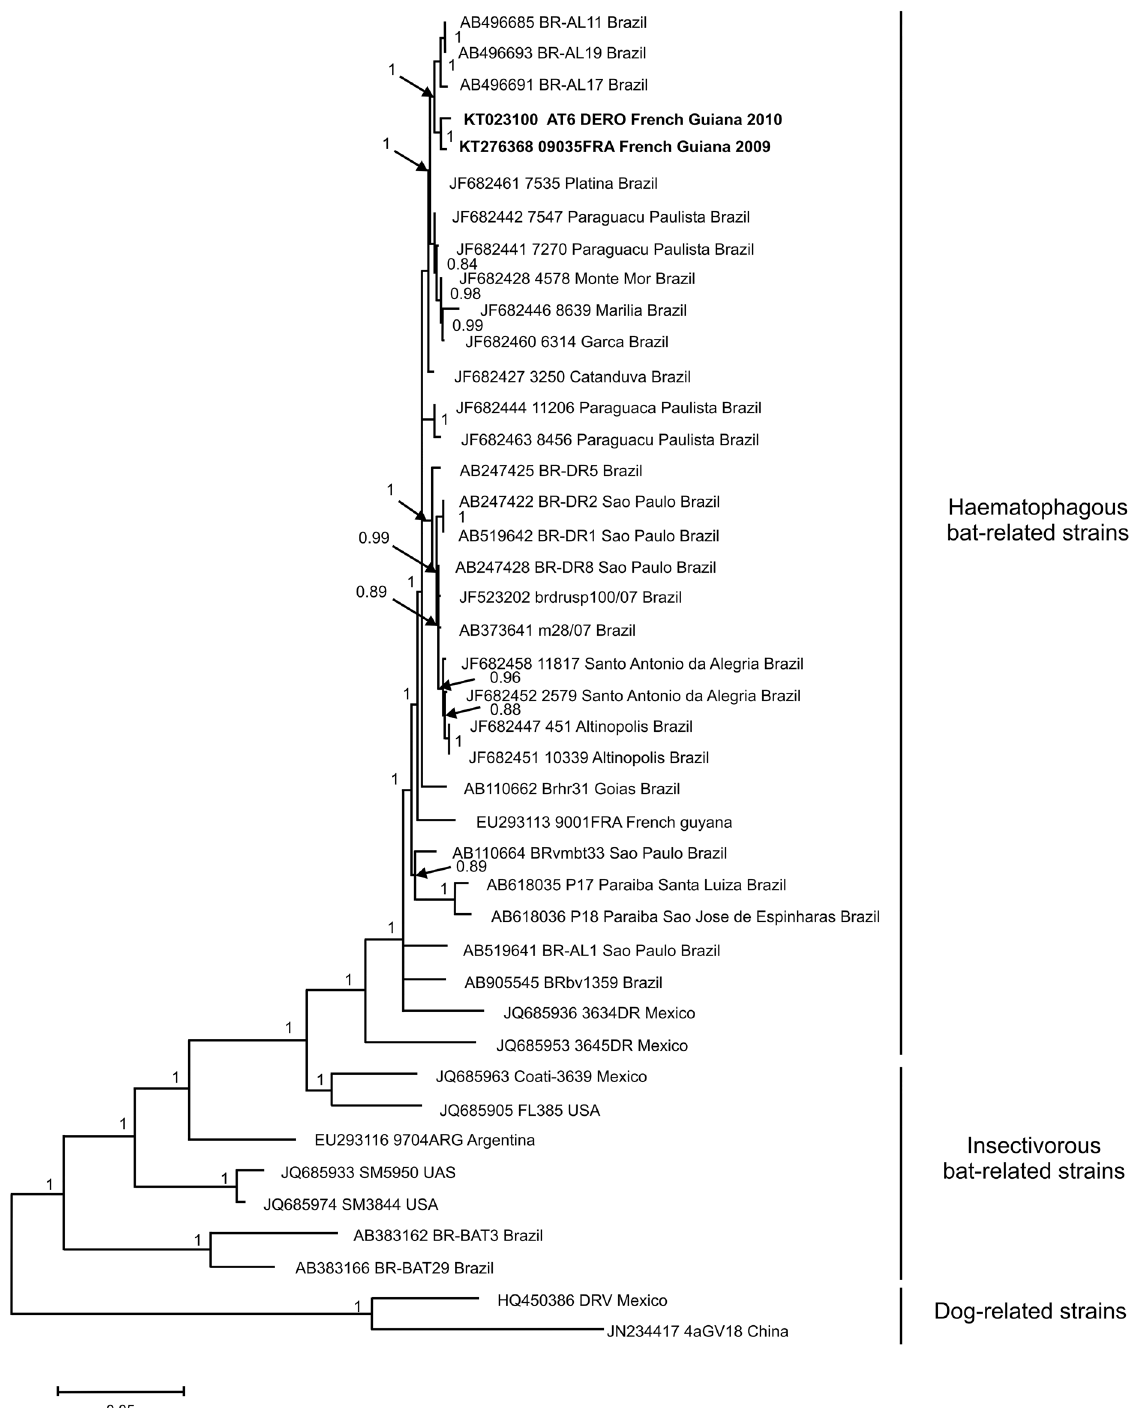
Fig 3. Phylogenetic tree constructed using Bayesian methods based on 1572 nucleotides of the complete glycoprotein gene. Virus names are associated with their accession numbers. Novel sequences generated from the two rabid bats in this study are shown in bold. Support for nodes is provided by the posterior probabilities of the corresponding clades. All resolved nodes have a posterior probability greater than 0.8. Scale bar indicates nucleotide sequence divergence among sequences.